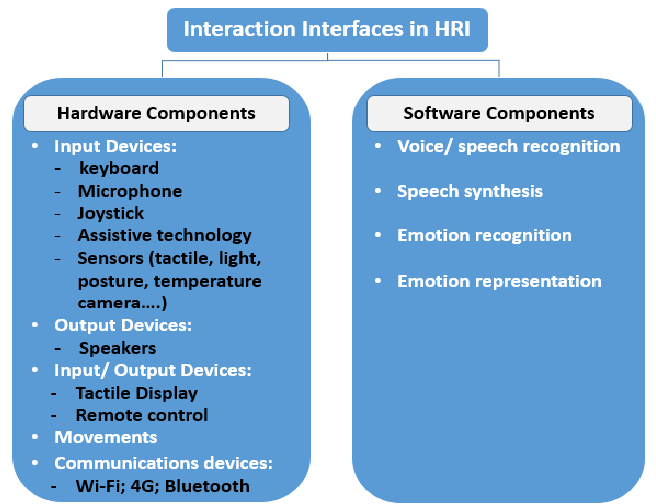
Figure 2. Interaction interfaces in human-robot interaction (HRI).